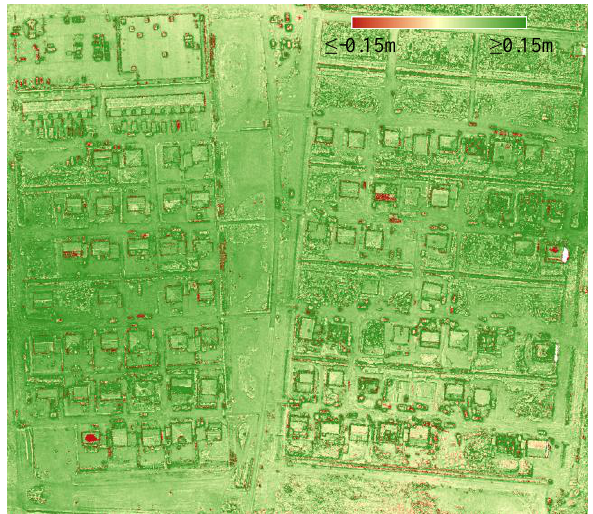
Figure 11: DSM difference of the second epoch between Pix4DMapper and PhotoScan in centimetre range (-15cm to